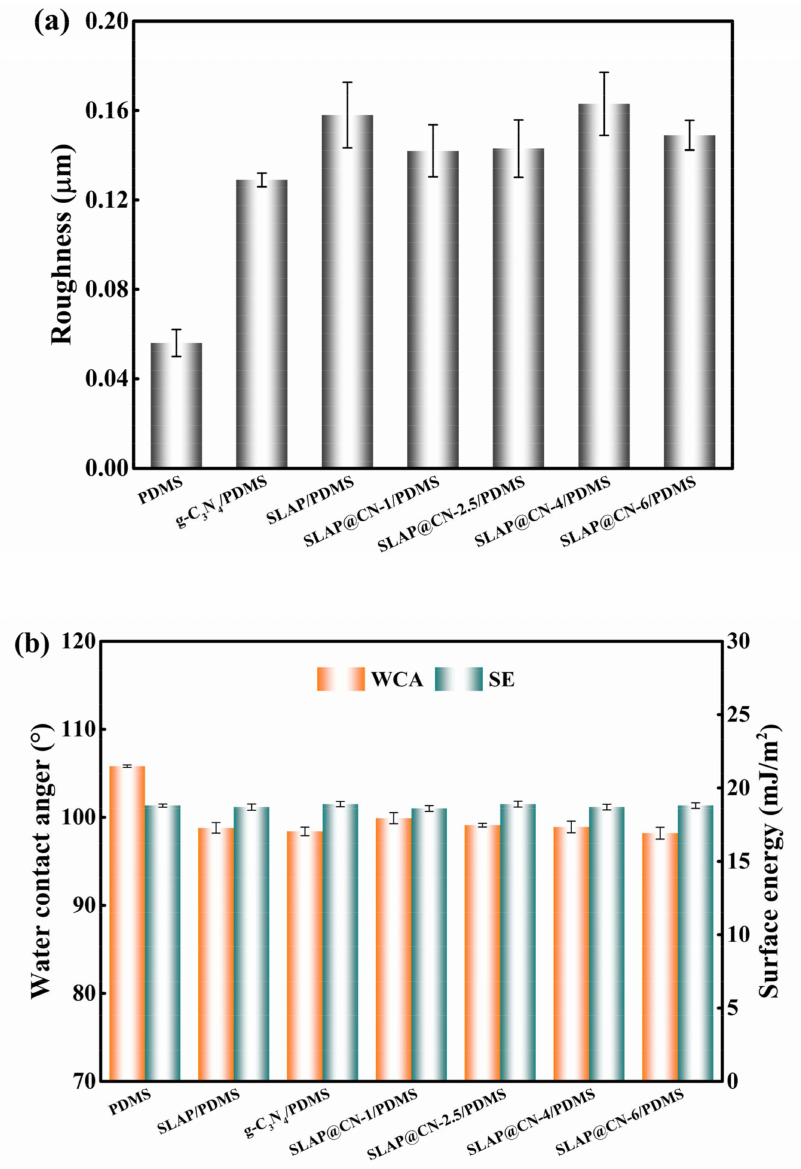
Figure 6. ( a ) Surface roughness of the coating; ( b ) water contact angle and surface energy of the